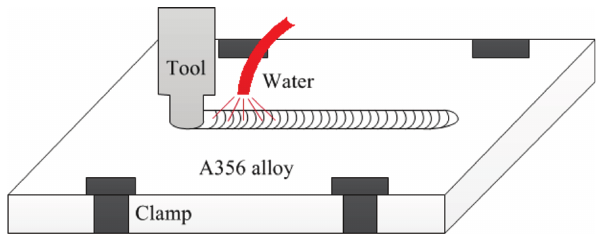
Figure 2: Schematic of the water cooling FSP process.